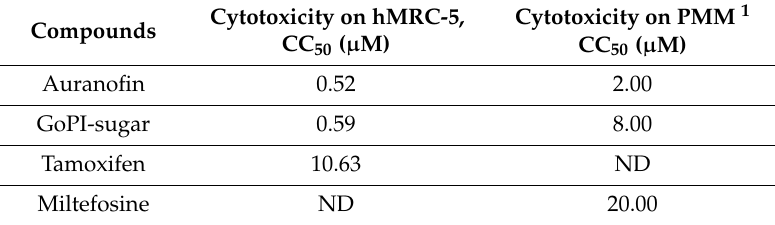
Table 10. In vitro cytotoxicity (CC 50 µ M) of gold(I) complexes in human fetal lung fibroblast (MRC-5) and primary mouse macrophages (from the L. infantum